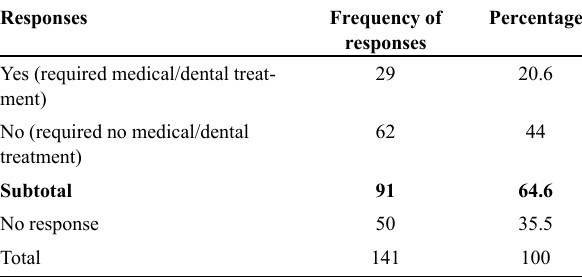
Table 3 - Distribution of responses per medical/dental treatment required for injuries occurring during the practice of contact sports.